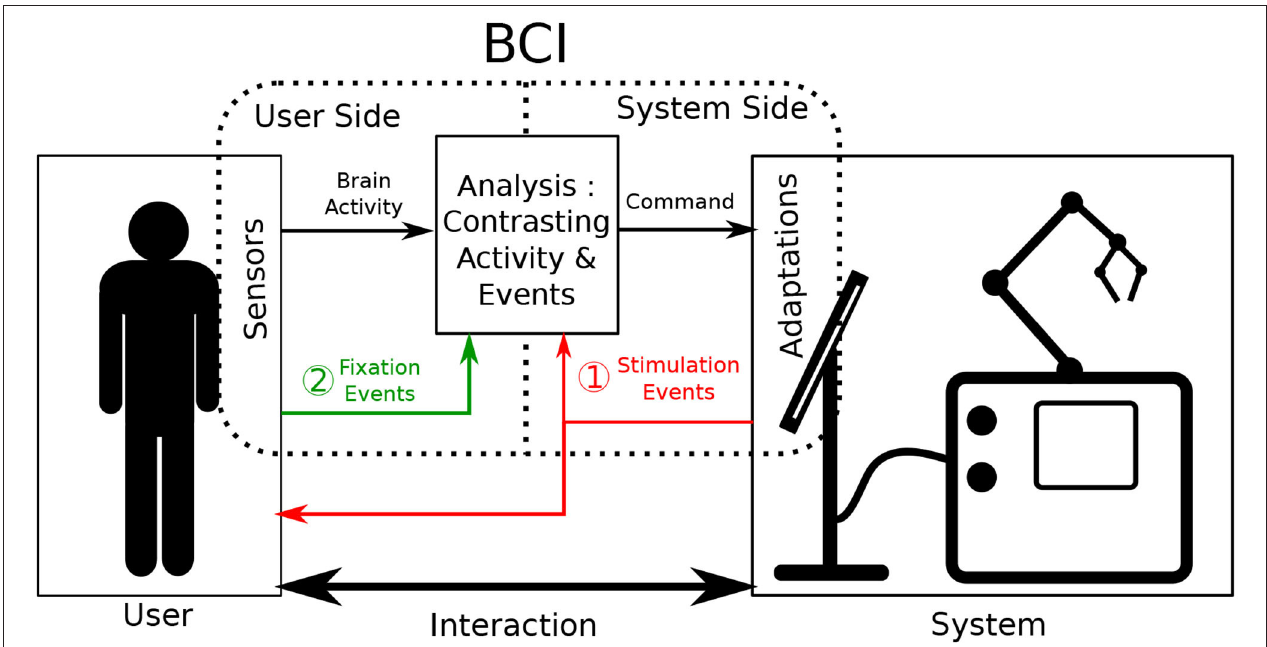
FIGURE 1 | Illustration of the functioning of Event-related potential Brain Computer Interfaces during interaction. Sensors are placed onto the user and adaptations are made on the system to augment interaction. The brain activity of the user is contrasted and analyzed as it relates to events. Classically (case 1 in red) these events are produced by system adaptations. In this work, we investigate the acquiring of events via sensors such as eye tracking (case 2 in